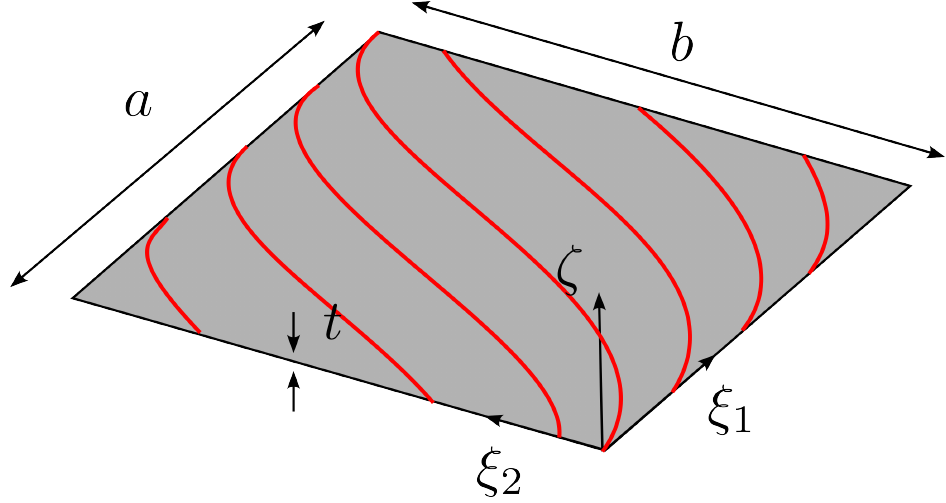
Figure 11. Variable stiffness